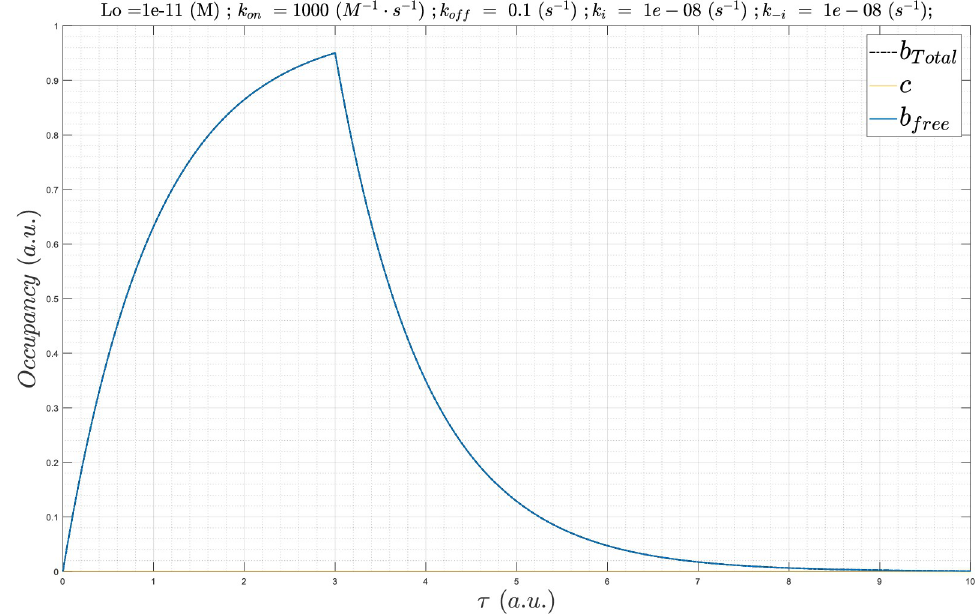
Fig 6. The buildup and decay phases of B total ( τ ) simulated using Eqs 6B and 6D (scenario 1). The maximum B total ( τ ) is normalized to 1.0, and always occurs at the normalized time τ = 3. The curve adopts a canonical “saw-tooth”